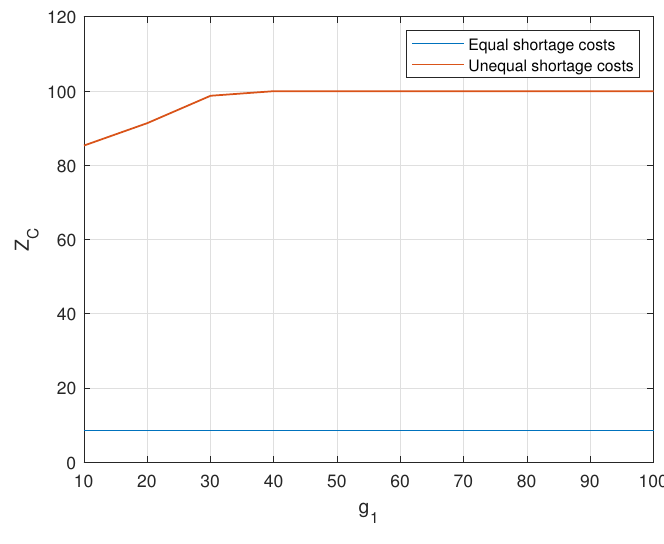
Figure 5. Effect of g 1 on Z C